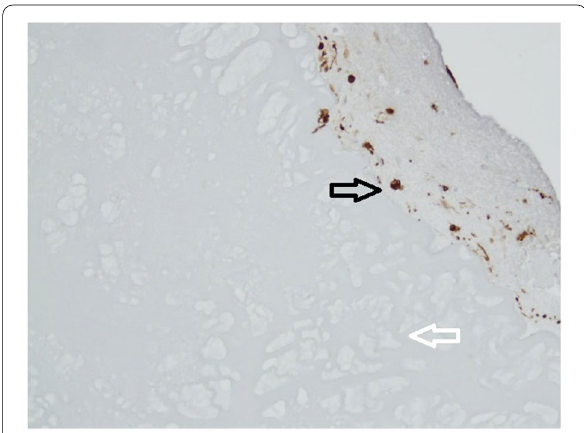
Fig. 6 Immunohistochemistry with S‑100 (Well 8). Scaffold in the lower corner (marked with white arrow), newly formed cartilage matrix in the upper corner (marked with black arrow). Sporadic staining with S‑100 at the periphery of the newly formed cartilage matrix and more abundant signals in the newly formed cartilage next to the scaffold (marked with black arrow). God adhesion of the newly formed extracellular matrix to the